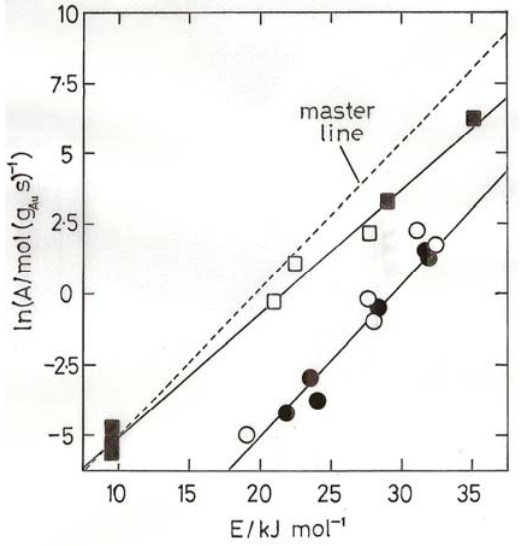
Figure 4. Compensation plot for CO oxidation over 4.5% Au/TiO (filled points) derived from ‘atomic rates’ (mol CO (g Au/TiO 2 particle sizes, 1.8–2.6 nm; circles, 5–11.8 nm.